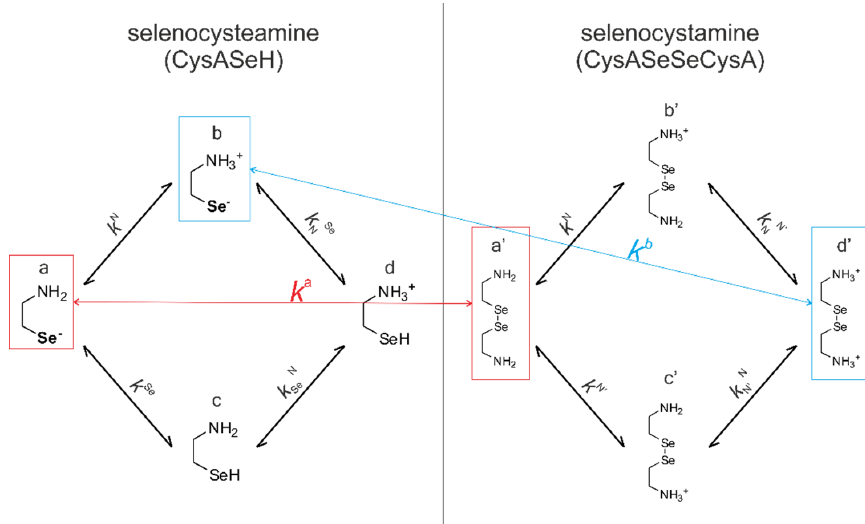
Figure 4. The coexisting protonation and redox microequilibria of selenocysteamine and selenocystamine; N, and Se labels denote the amino, and selenolate groups, respectively.